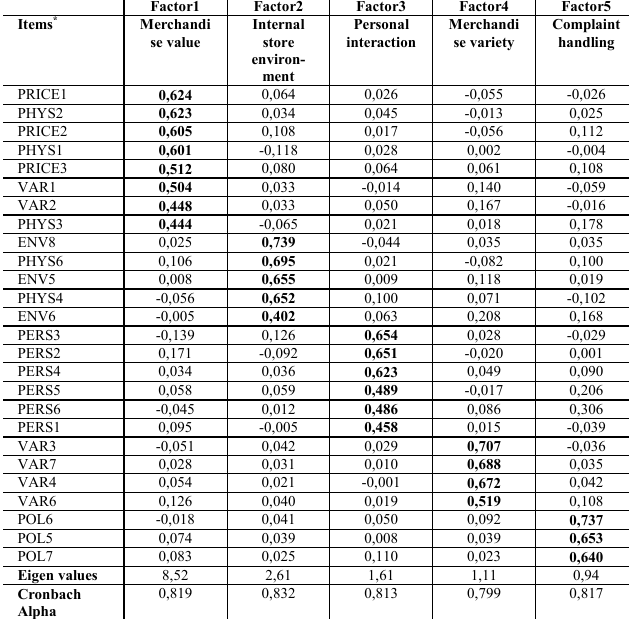
Table 2: Rotated factor